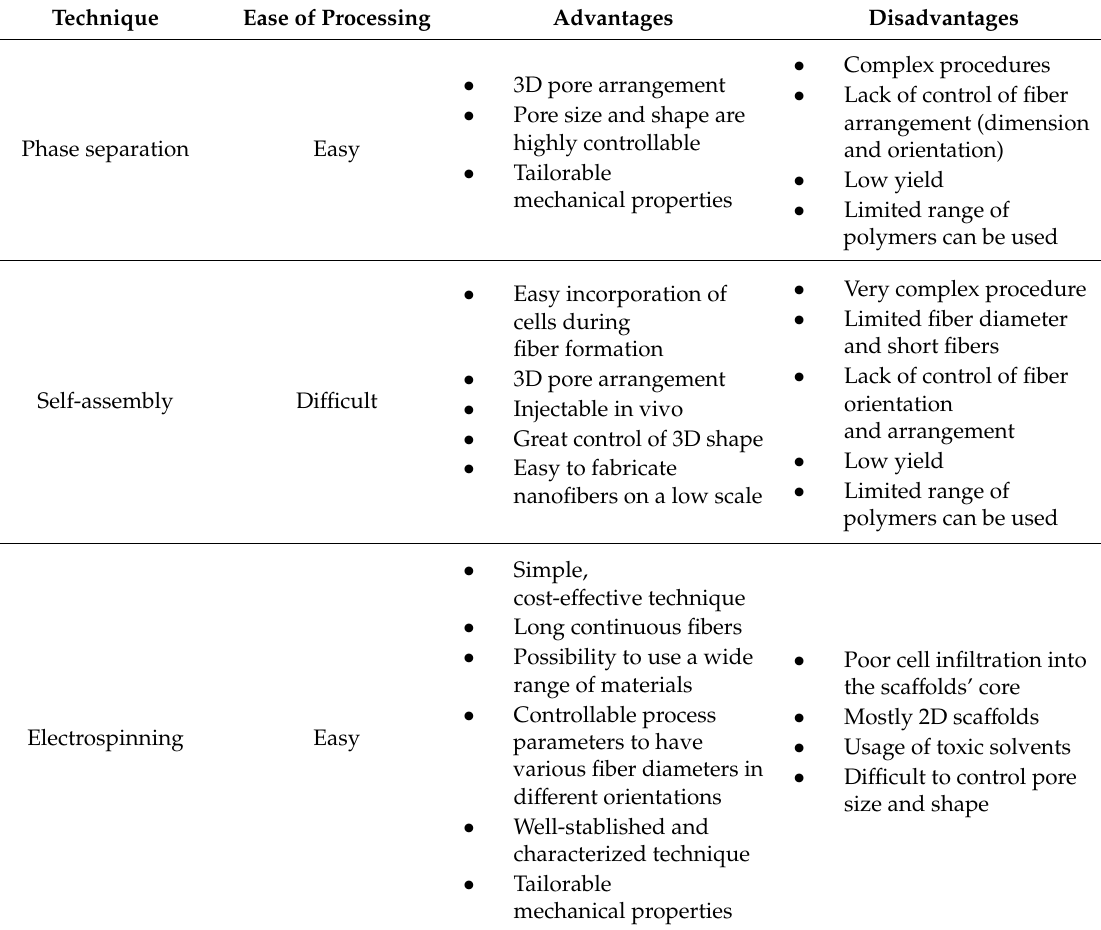
Advantages and disadvantages of di ff erent techniques for polymer nanofibrous sca ff old